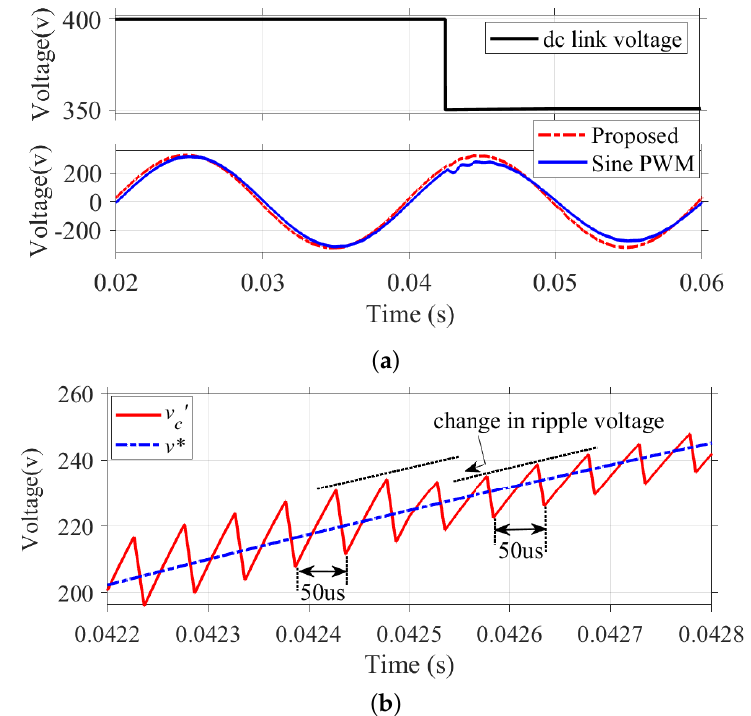
Figure 16. Variation of output voltage for a step reduction in V dc : ( a ) Simulated waveform of output voltage for varying dc bus voltage. ( b ) Output voltage waveform enlarged around step